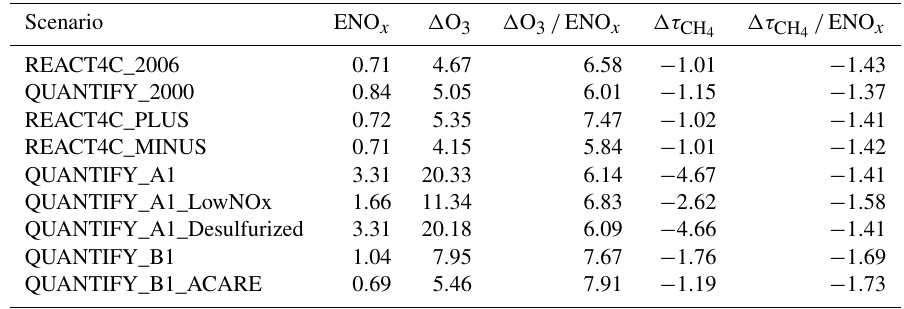
Table 4. Annual aircraft NO x emissions (ENO x ,TgN), ozone burden variation ( (cid:49) O 3 , TgO 3 ), ozone to NO x sensitivity ( (cid:49) O 3 / ENO x , TgO 3 / TgN), methane lifetime variation ( (cid:49)τ CH simulations.